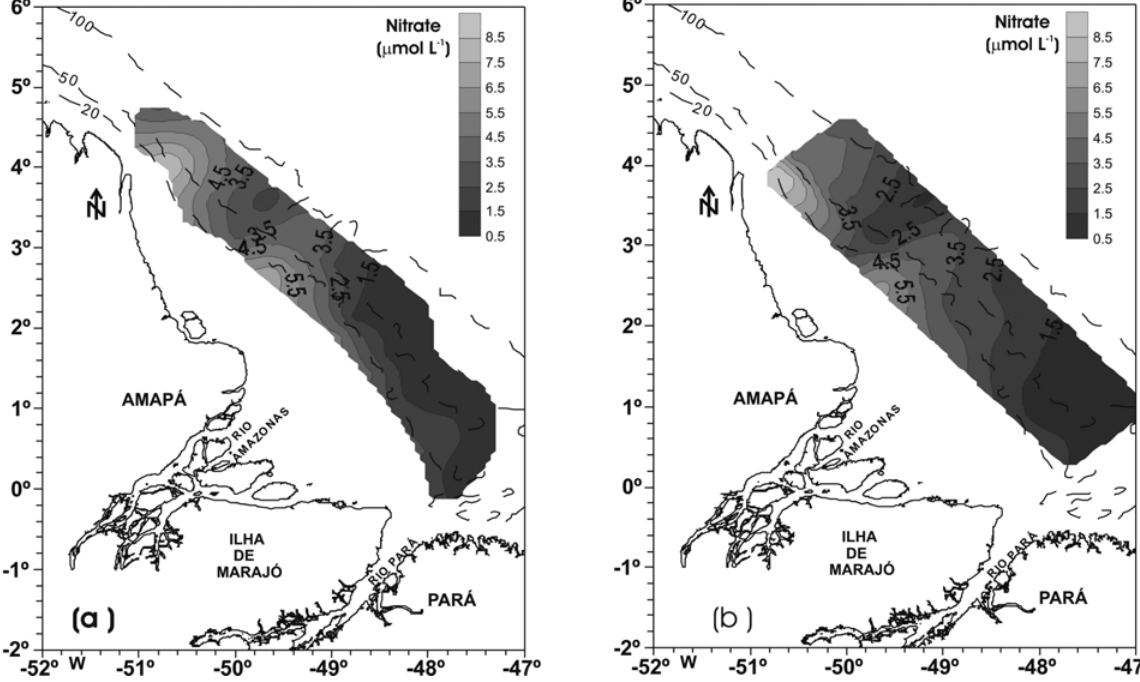
Fig. 8–DistributionofthesuperficialconcentrationofthenitrateduringOperationNorteIV(fallingdischargeoftheAmazonriver): (a)REVIZEE data; and (b) MACC-2D model